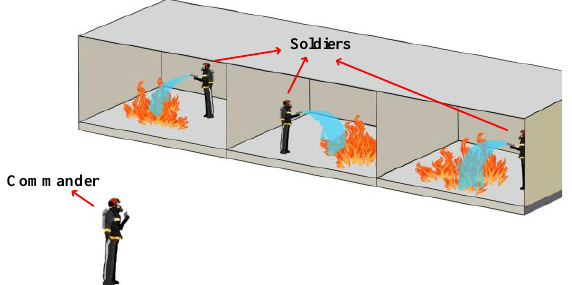
Figure 1. Cooperative localization in the building environment.